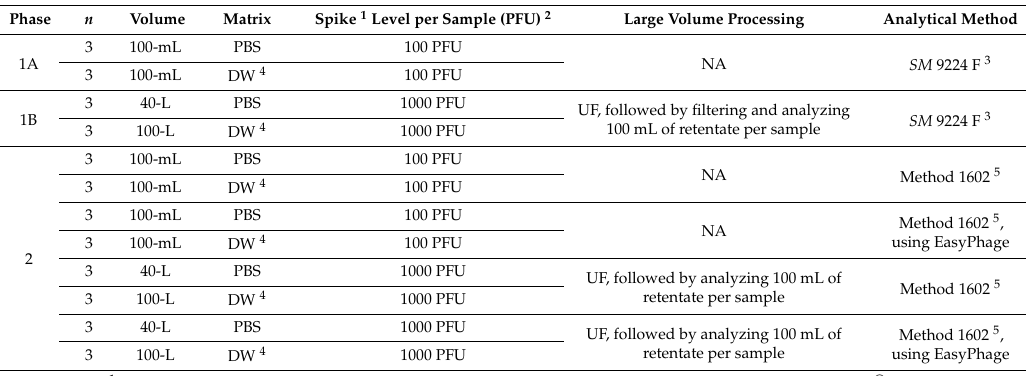
Table 1. Summary of key preliminary QC criteria